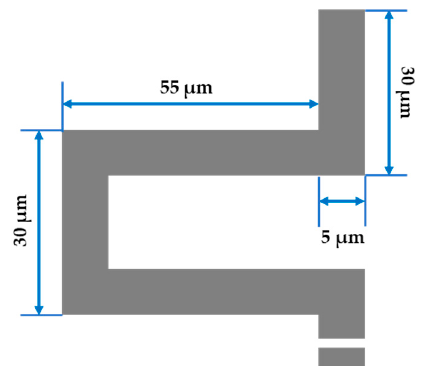
Figure A1. The element size for the coupled folded beam.